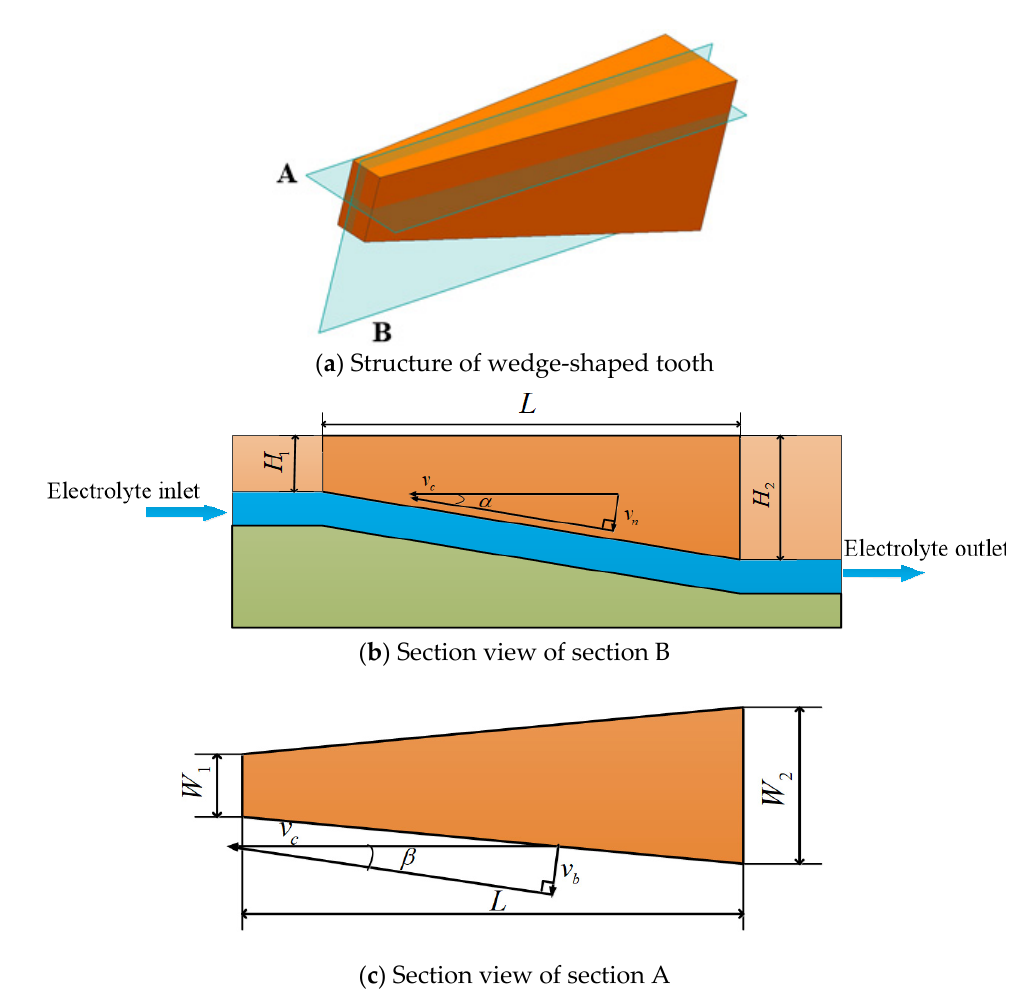
Figure 3. Schematic diagram of wedge-shaped tooth structure.